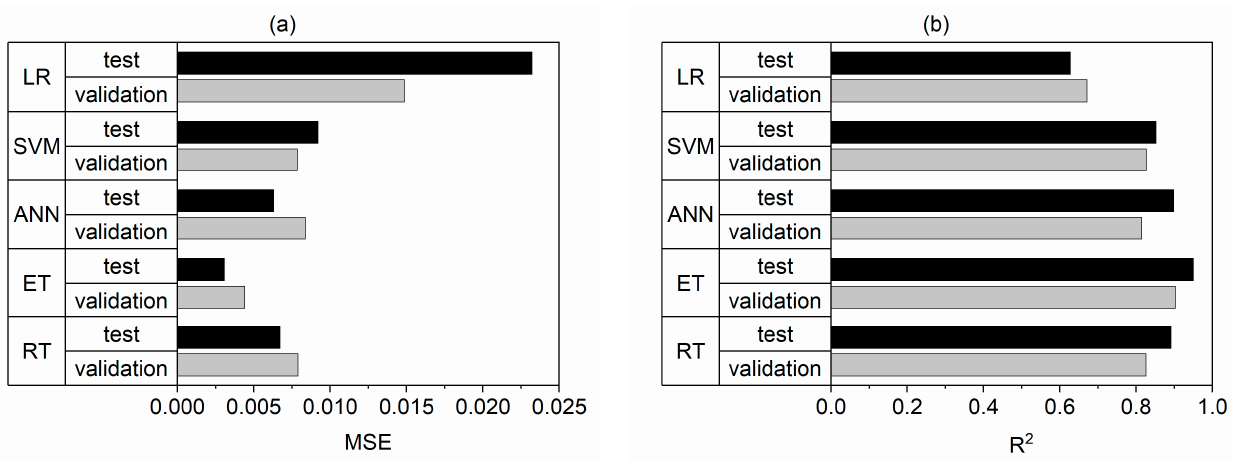
Figure 3. Comparison of the prediction accuracy for the best model within different ML approaches (RT, ET, ANN, and SVM) and linear regression (LR): ( a ) MSE for validation and testing, ( b ) R 2 for validation and testing.